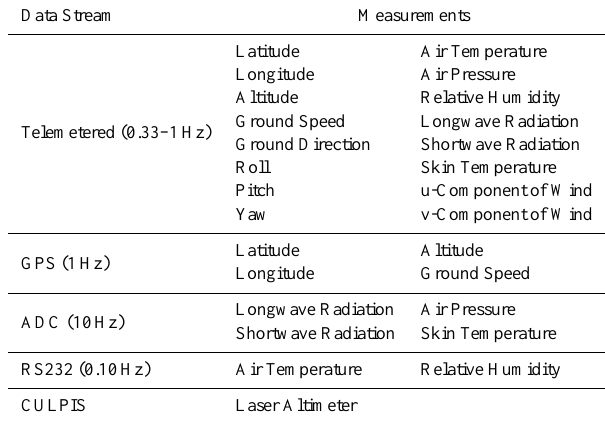
Table 5. Available data for each of the sixteen September 2009